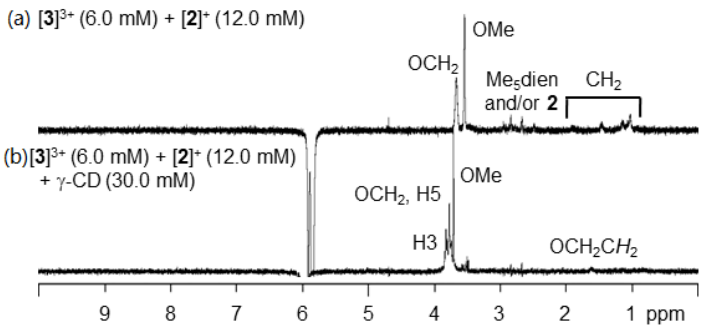
Figure 3. 1 H-NMR spectra with the rotating-frame Overhauser effect (ROE) difference mode. ( a ) [ 3 ] 3+ (6.0 mM) + [ 2 ] + (12.0 mM). ( b ) [ 3 ] 3+ (6.0 mM) + [ 2 ] + (12.0 mM) + γ -CD (30.0 mM).